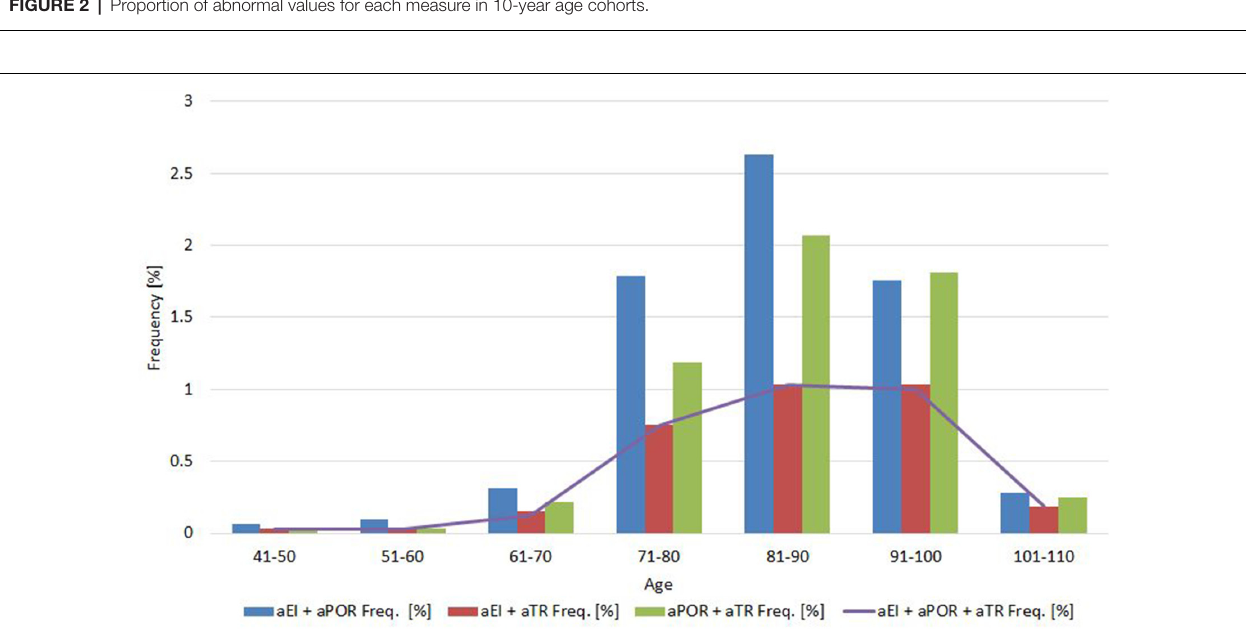
FIGURE 2 | Proportion of abnormal values for each measure in 10-year age cohorts.